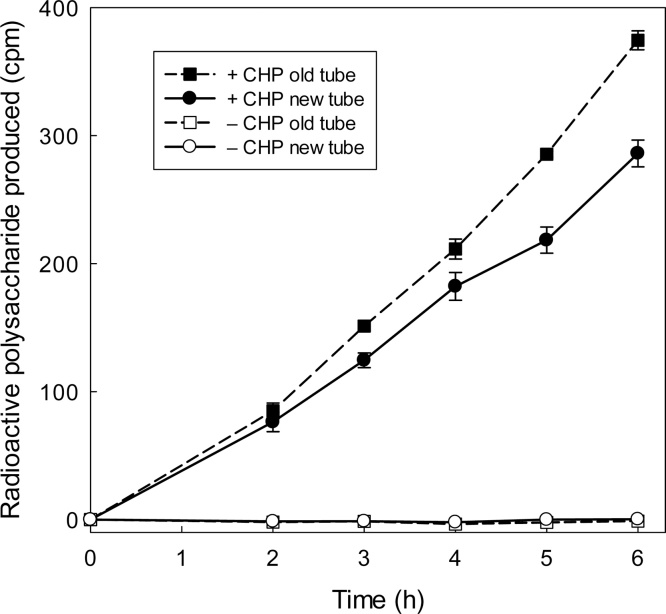
CHP releases glass-bound XTH24 into solution. A dilute solution of XTH24 (150 μl; protein concentration 2.16 μg/ml) was incubated in a borosilicate glass tube for 2 h. The tube was then rinsed with H2O to remove soluble enzyme, and each tube then received 300 μl of an XET reaction-mixture [100 μM [3H]XXXGol, 0.3% xyloglucan and 150 mM MES (Na+, pH 5.5); added at ‘time 0′ on the x-axis], either with 1.5 mg/ml CHP or without CHP. After 2 h gentle shaking at 20 °C in this (‘old’) tube, half the solution was transferred into a new tube. At intervals thereafter, samples were assayed for [3H]polysaccharide. A yield of 100 cpm of 3H-polysaccharide indicates 7.4 pmol XXXGol incorporated.